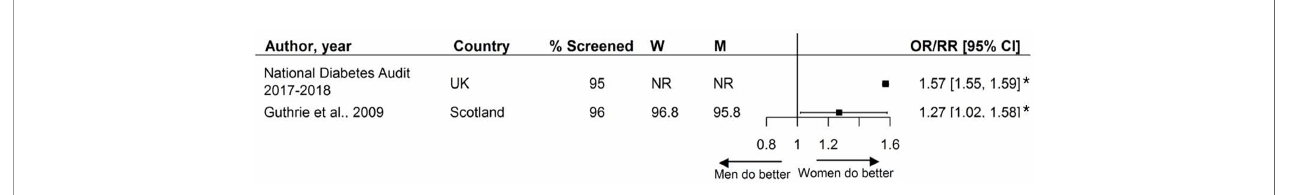
FIGURE 9 | Assessment of smoking status, expressed as adjusted odds ratios (OR) with corresponding 95% con fi dence intervals (CI). W = % of screened women; M = % of screened men; Men = reference. * = statistically signi fi